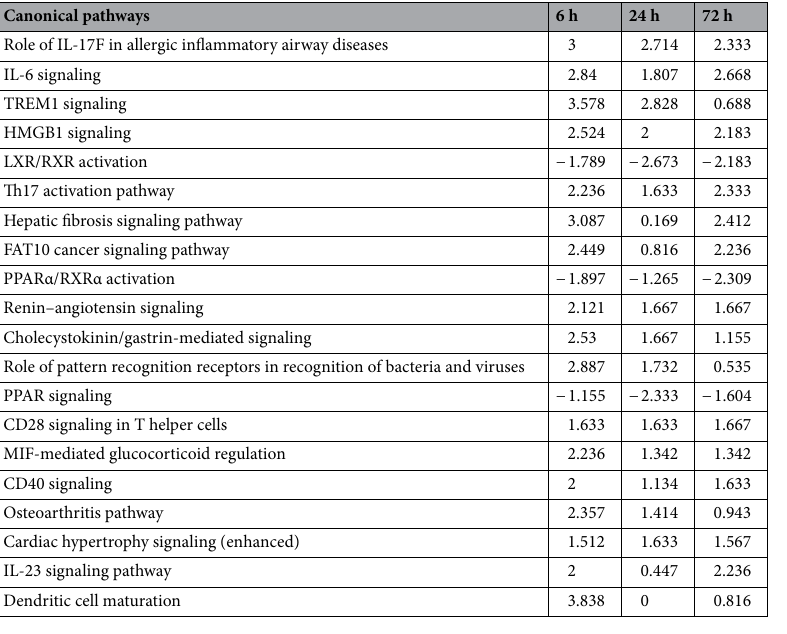
Table 1. Top 20 canonical pathways in M. intracellulare -infected canine MDMs as determined by comparison analysis of IPA. The canonical pathways are indicated by the z-score determined from the pathway activation